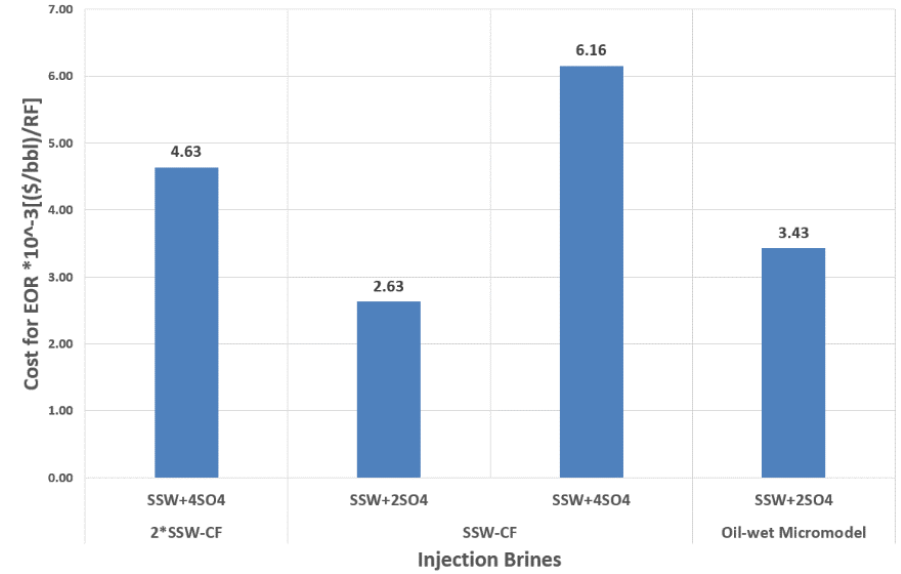
Figure 23. Price of the spiked amount of Sulfates in (USD / bbl.) / RF of injected modified SSW to obtain the recovery factor from Core plugs.